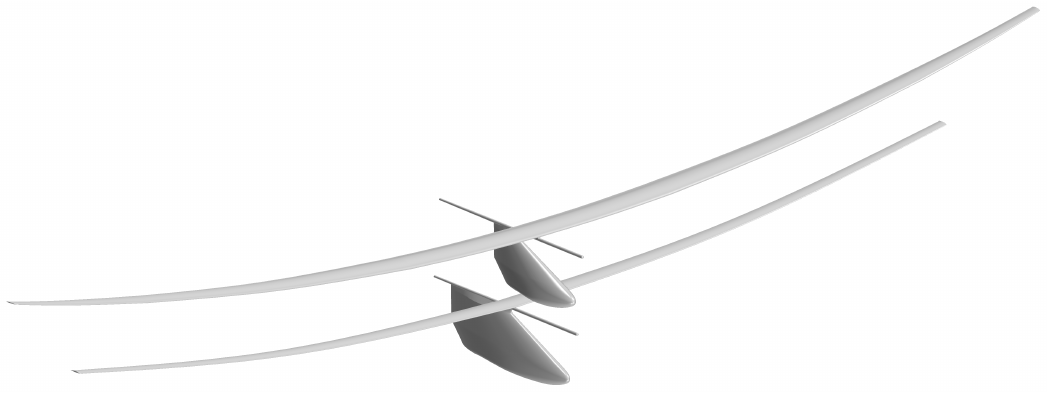
Figure 22. Comparison of wing and fuselage (upper: Daedalus; lower: optimized dual-Human-Powered Aircraft (HPA)).